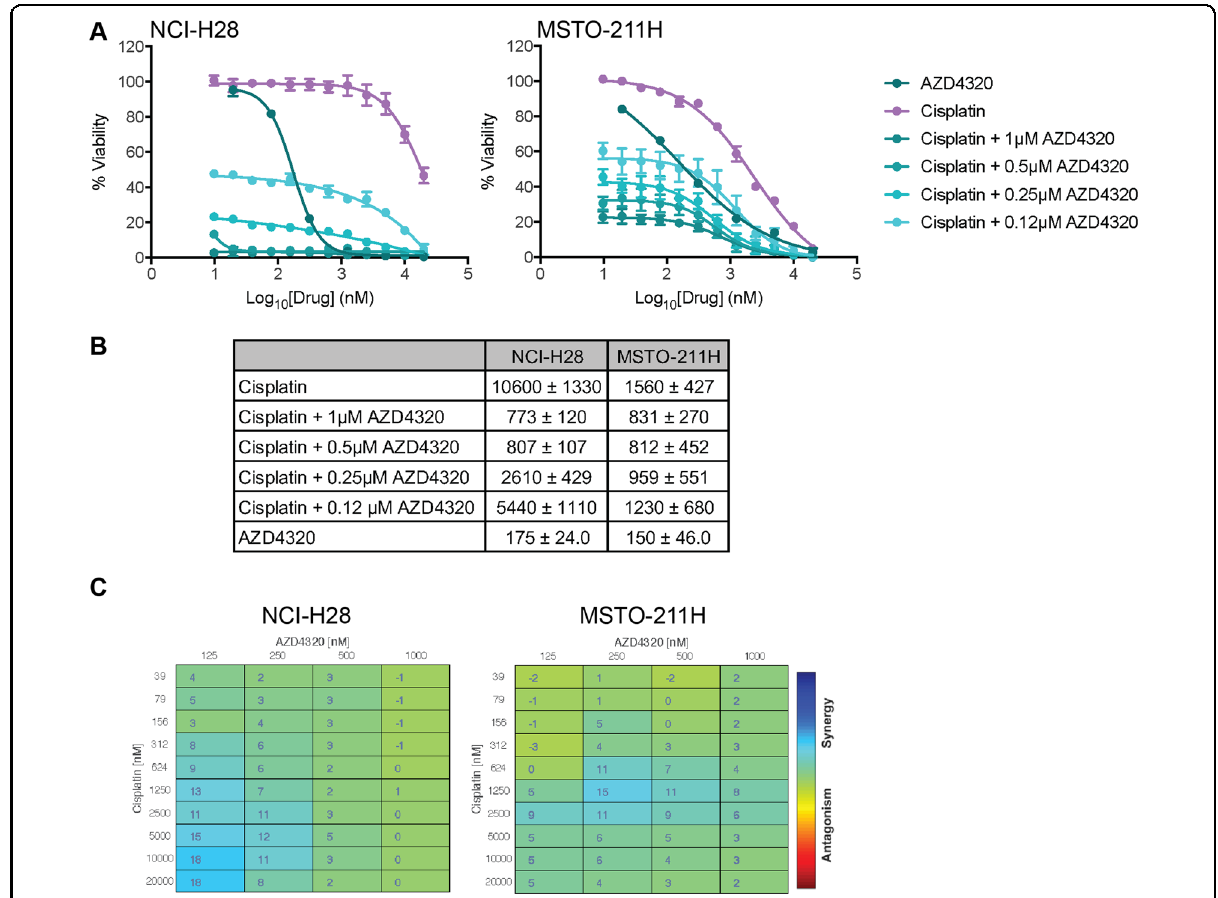
Fig. 3 AZD4320 enhances MPM cell killing by Cisplatin. A Cisplatin alone is less effective than AZD4320, however, the combination increases cell killing. Cell viability was determined using CellTiter-Glo assays after 72 h treatment. Data represent mean ± SEM ( n = 3). B Summary of EC 50 values for treatments in A . C Synergy analysis of combinations in A performed with Combene fi t software using the BLISS synergy